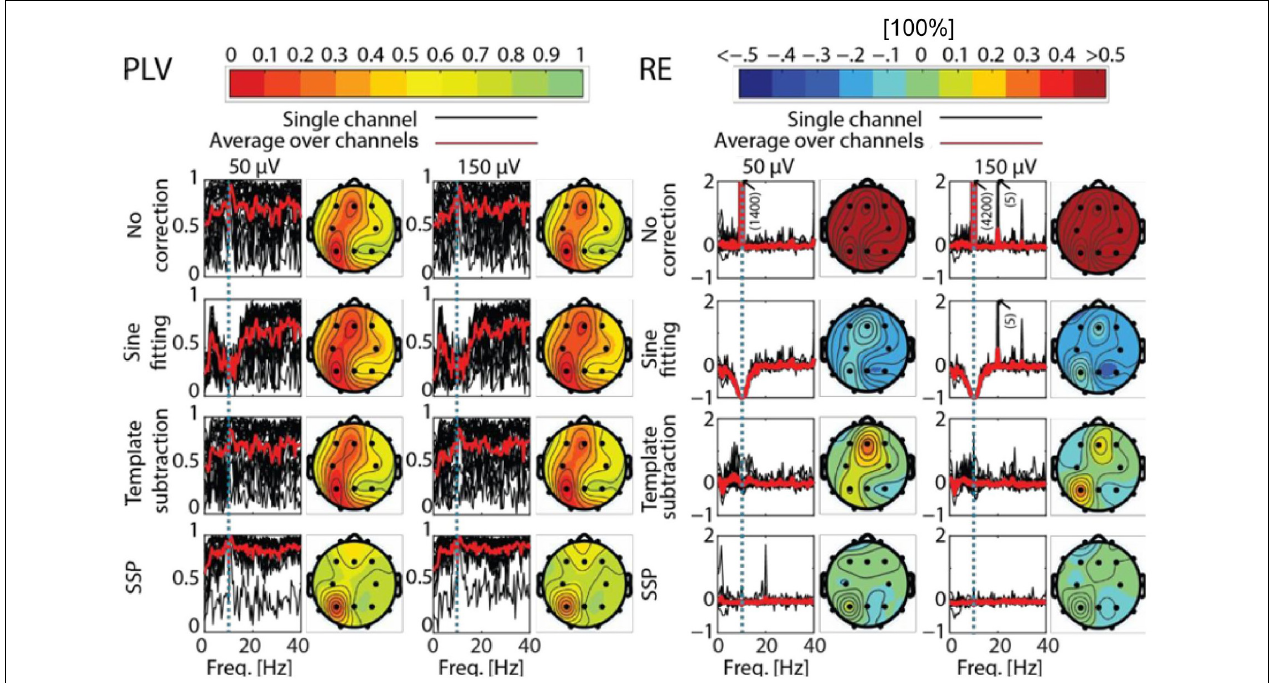
FIGURE 5 | Phase-locking value (PLV) and relative error (RE) as function of frequency and different channels after artifact correction. PLV (left) and RE (right) for the different correction methods and tACS conditions as compared to the baseline. The black curves show PLV and RE as function of frequency in different channels, the red curve showing the average of the black curves. The dotted blue line depicts the stimulation frequency. Corresponding topographies show the mean value of the channel-specific black curves averaged across frequencies 0 − 40 Hz. In the PLV column, red indicates low PLV, meaning big distortions between baseline and corrected EEG (Note that PLV is a unitless measure). In the RE column, red means there was artifact left in the data, while blue depicts an overcorrection. Note that the color map of RE is thresholded to 50% absolute error and the plots in the RE section show only values between –1 and